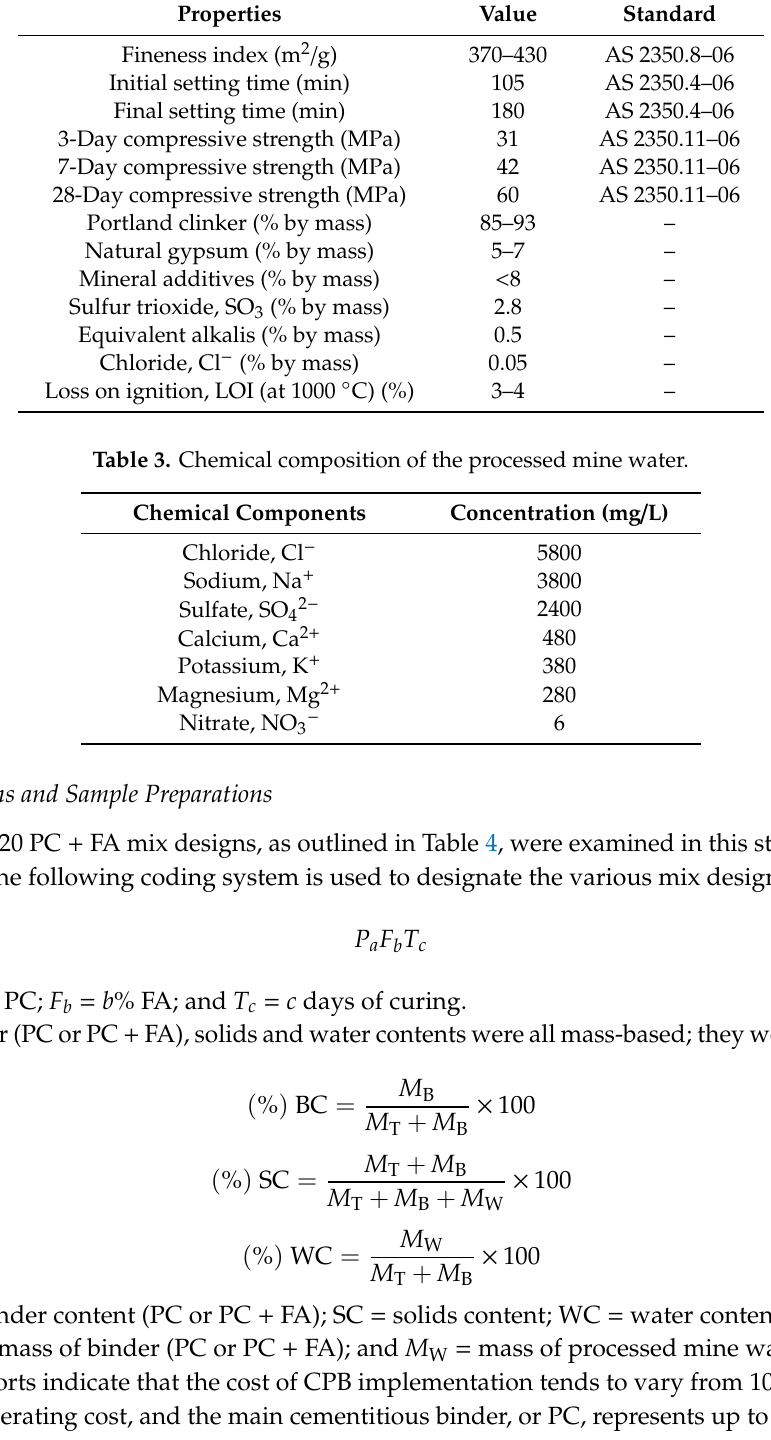
Table 2. Physical and chemical properties of PC.